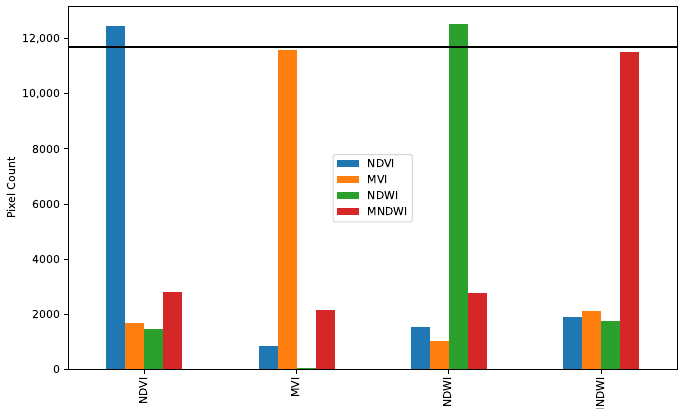
Figure 4. Importance of the indices used for the baseline refinement, represented as a count of the number of pixels identified as non-mangroves using the 44 reference sites using each index as a base. Using each index as the base (x-axis), the number of additional non-mangrove pixels identified using each of the other indices is shown. This illustrates that the NDVI and NDWI individually identified more non-mangrove pixels than the MNDWI and MVI pixels, but the MNDWI was more complementary to the other indices. Acronym definitions: normalised difference vegetation index (NDVI), normalised difference water index (NDWI), modified normalised difference water index (MNDWI), mangrove vegetation index